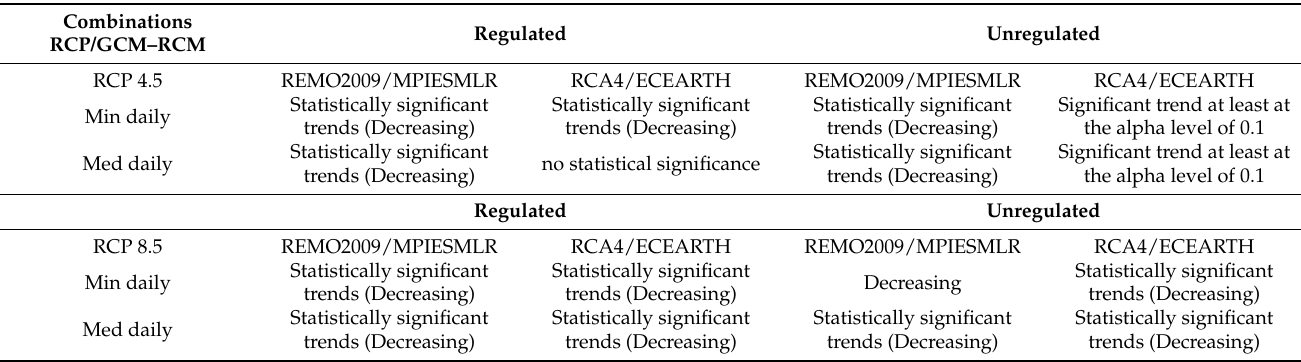
Table 6. Overall results of trend